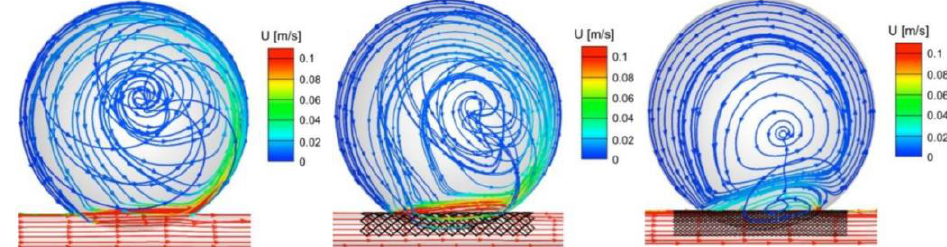
Fluids 2022 , 7 , x FOR PEER REVIEW